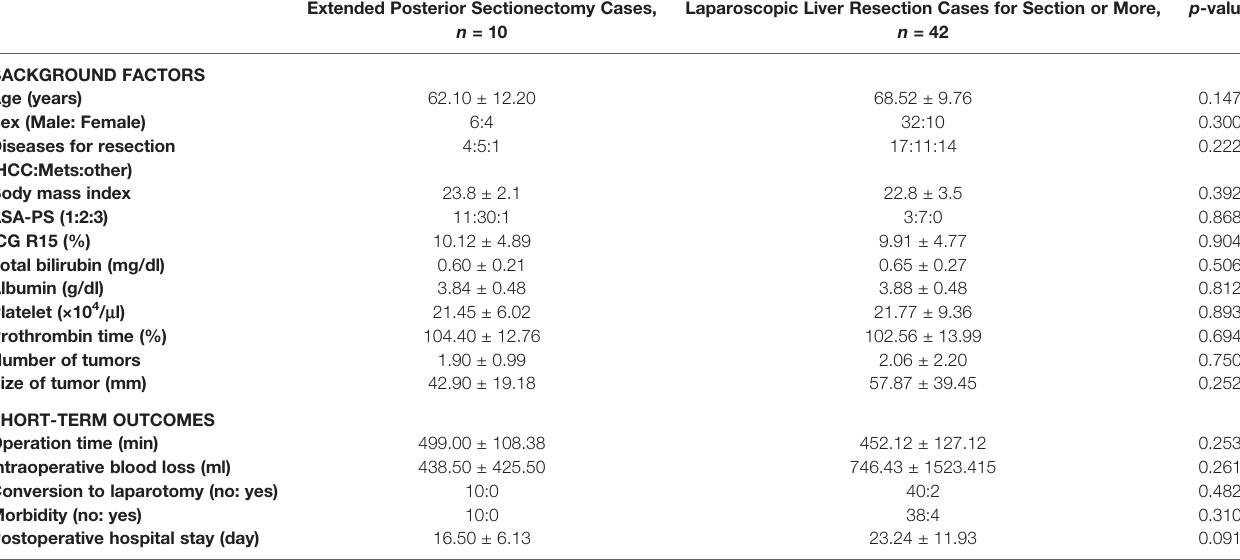
TABLE 1 | Comparison between laparoscopic extended posterior sectionectomy cases and laparoscopic liver resection cases for section or more in background factors and postoperative short-term outcomes. Extended Posterior Sectionectomy Cases, Laparoscopic Liver Resection Cases for Section or More, n = 10 n =